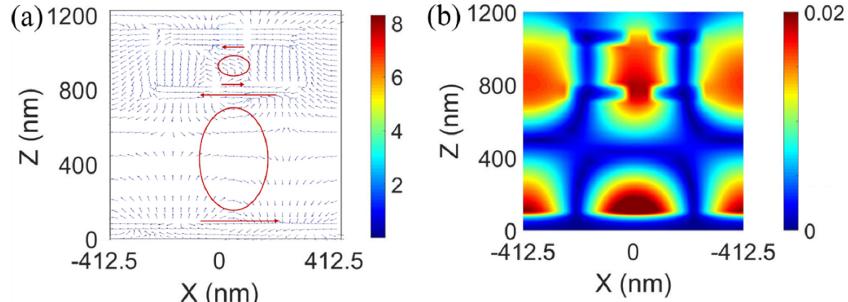
Figure 5. ( a ) Electric displacement |𝑫| distribution and ( b ) magnetic field |𝑯| distribution for one unit cell at 1144 nm.